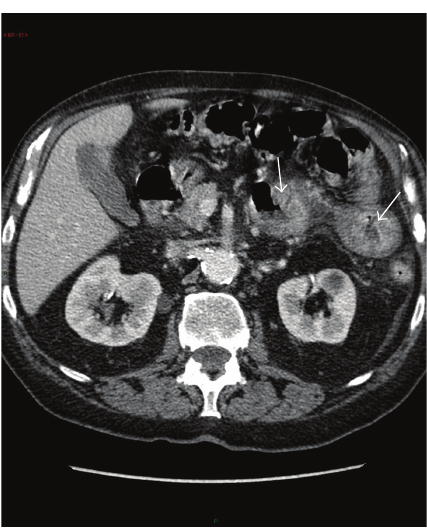
Figure 1: Abdomen computed tomography after intravenous contrast. Significant thickening of the Treitz angle and proximal jejunum (arrows), with infiltration of the loco-regional fat.